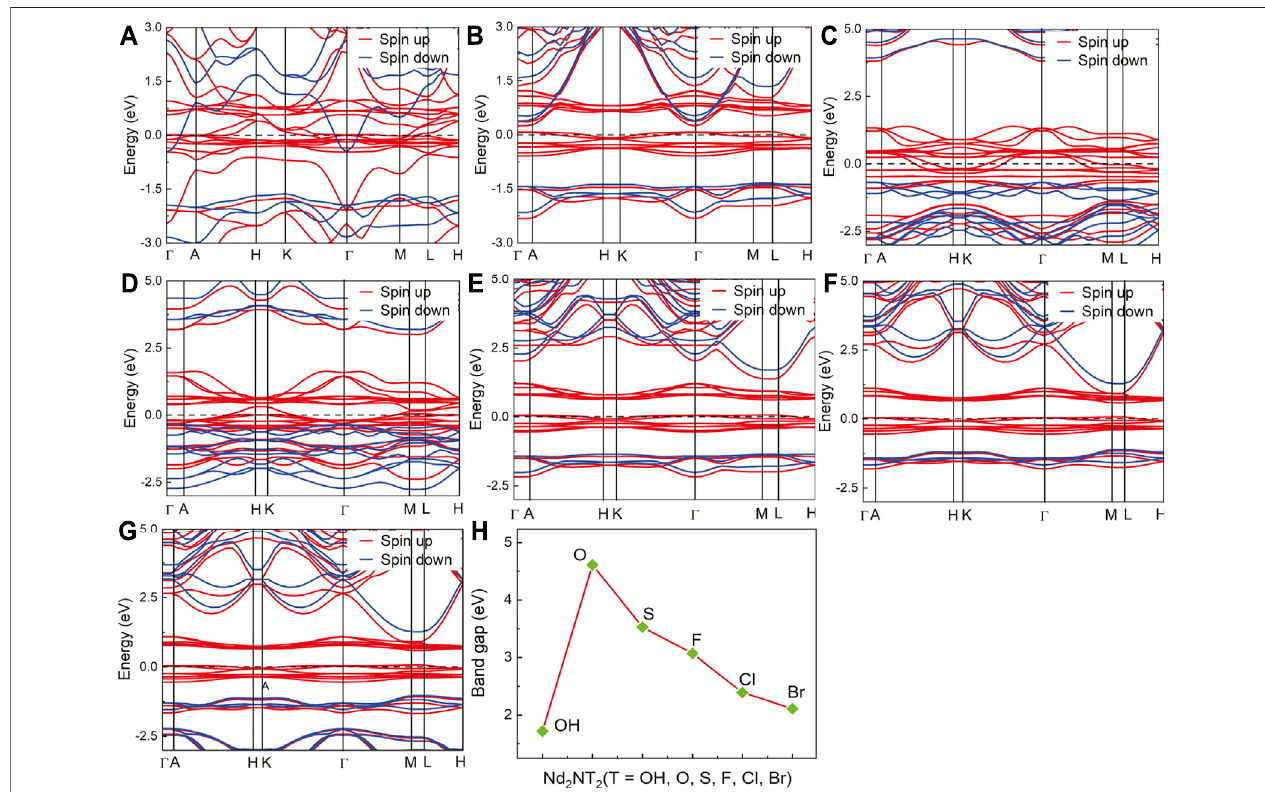
FIGURE3| Energybandstructureandbandgapwidthdiagramofthetwo – dimensionalMXenematerialsNd 2 NandNd 2 NT 2 (T=OH,O,S,F,Cl,andBr). (A) Nd 2 N, (B) Nd 2 N(OH) 2 , (C) Nd 2 NO 2 , (D) Nd 2 NS 2 , (E) Nd 2 NF 2 , (F) Nd 2 NCl 2 , (G) Nd 2 NBr 2 , and (H) band gap width diagram.